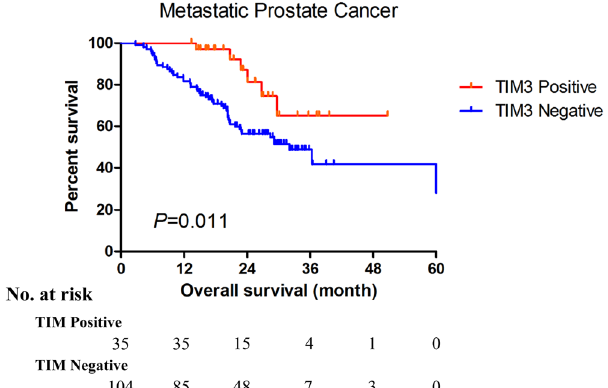
Figure 2. The Kaplan-Meier plot of overall survival in metastatic prostate cancer patients (according to TIM3 expression level).